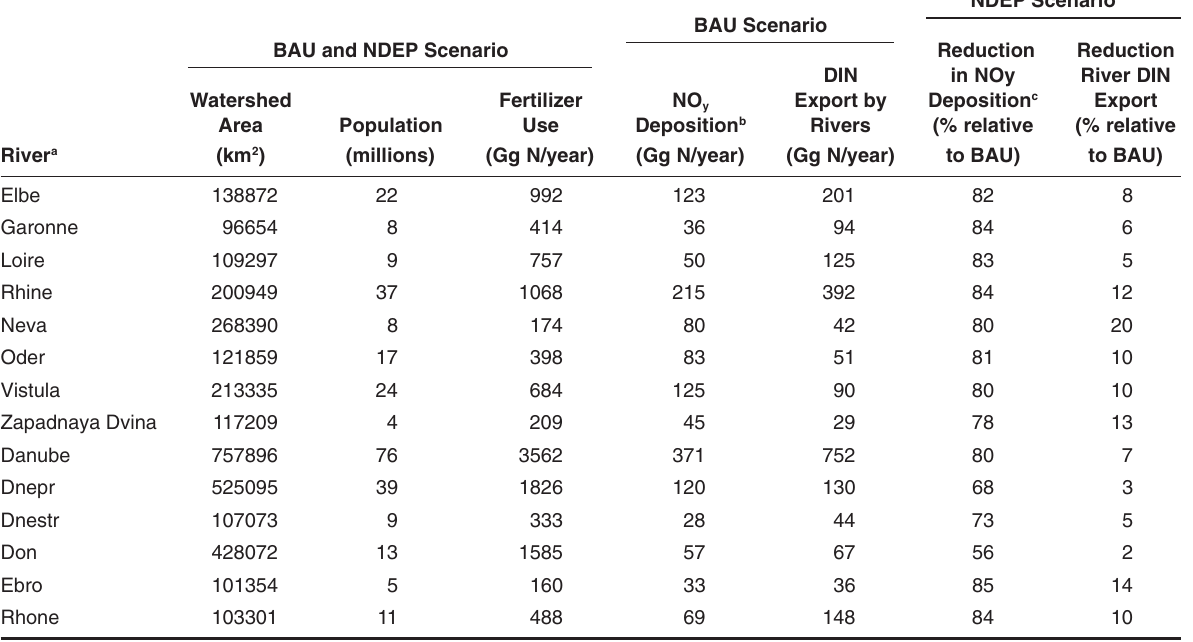
Results for Selected Rivers in Europe. N-Model Inputs of Watershed Area, Population, Fertilizer Use, and NO Deposition Rates. Calculated y DIN Export Rates for a BAU Scenario and NDEP Scenario for 2050.